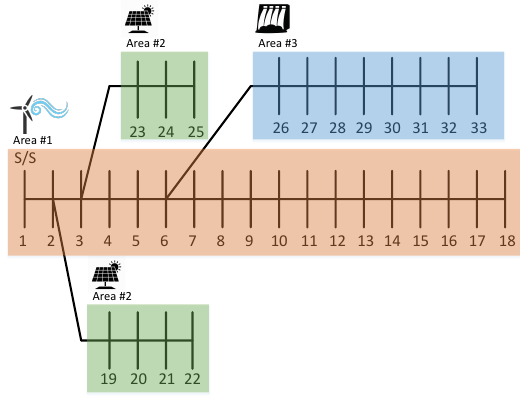
Figure 3. 33 bus system divided in three areas.